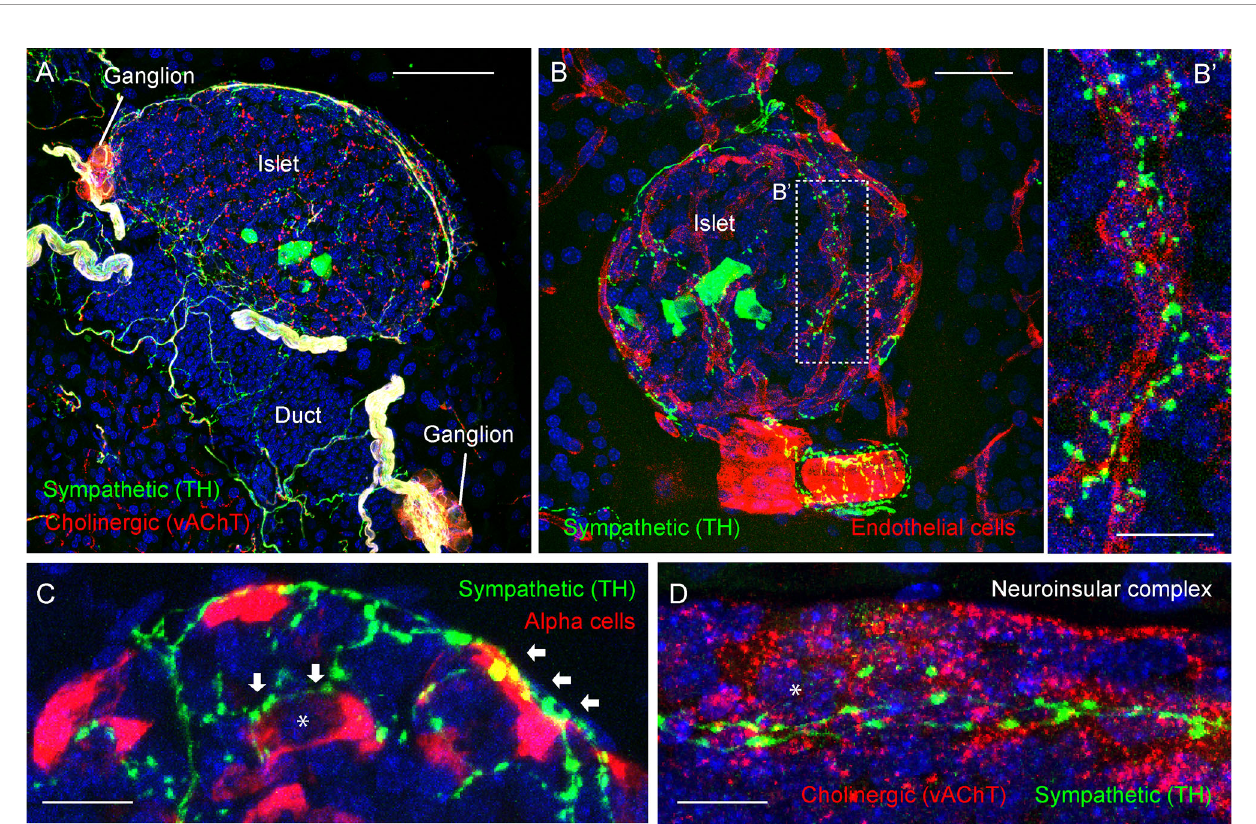
FIGURE 3 | Adrenergic innervation of the endocrine pancreas (photomicrographs are from experiments conducted by Dr. Joana Almaca, unpublished data). (A) Mouse pancreatic section immunostained for the sympathetic marker tyrosine hydroxylase (TH, green), the cholinergic marker vesicular acetylcholine transporter (vAChT, red), and DAPI (blue); scale bar 50 µm. (B-B ’ ) Mouse pancreatic section immunostained for TH (green), endothelial marker CD31 (red), and DAPI (blue); scale bars 20 µm (B) and 10 µm (B ’ ) . (C) Mouse pancreatic section immunostained for TH (green), glucagon (red), and DAPI (blue); scale bar 10 µm. (D) Mouse pancreatic section immunostained for TH (green), vAChT (red), and DAPI (blue); scale bar 10 µm. TH-positive fi bers can be seen along the perivascular space of a large blood vessel (B) and intra-islet capillaries (B ’ ) . TH-positive varicosities contact endothelial vascular cells (B ’ ) , endocrine a -cells ( arrows in C ), and neurons within a neuroinsular complex (D) . Asterisks denote an alpha cell (in C ) and a neuron (in D